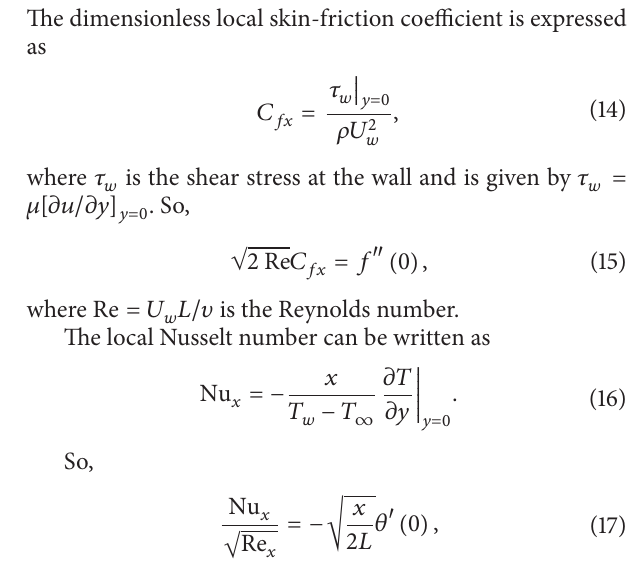
where 𝑐 and 𝑎 are constants with 𝑐 > 0 and 𝑎 ≥ 0 (for without any free stream 𝑎 = 0